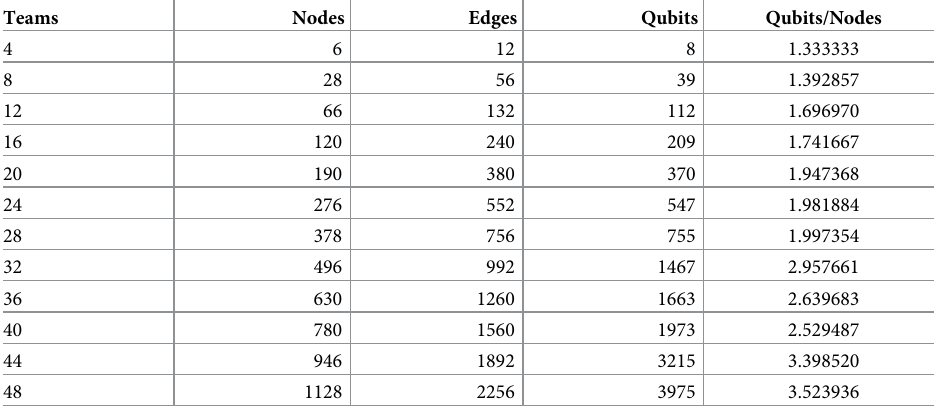
Table 3. Number of nodes and edges of the source graph and used qubits in MDRRTs. Teams Nodes Edges